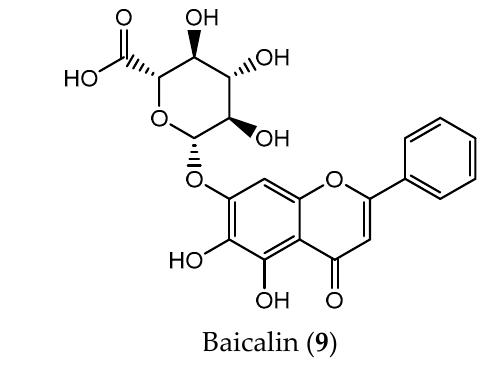
Figure 2. Natural chiral flavones with antitumor activity.